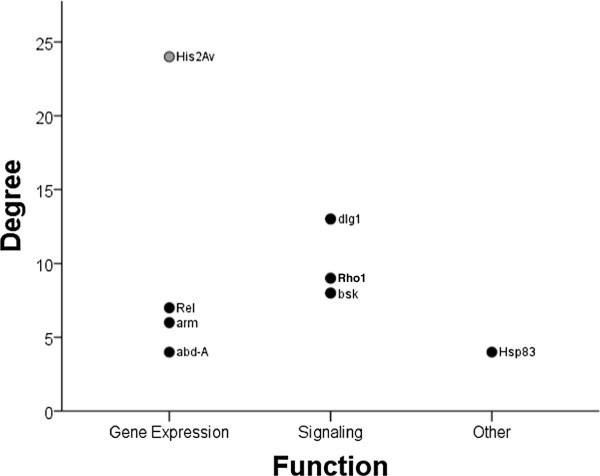
Degree of the highest connected gene of each network. Black hubs are from networks created with brain gene expression and grey hubs are from networks created with whole body gene expression.